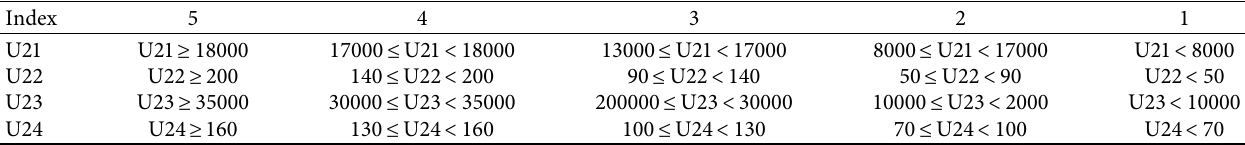
Table 2: Scoring standard 2.